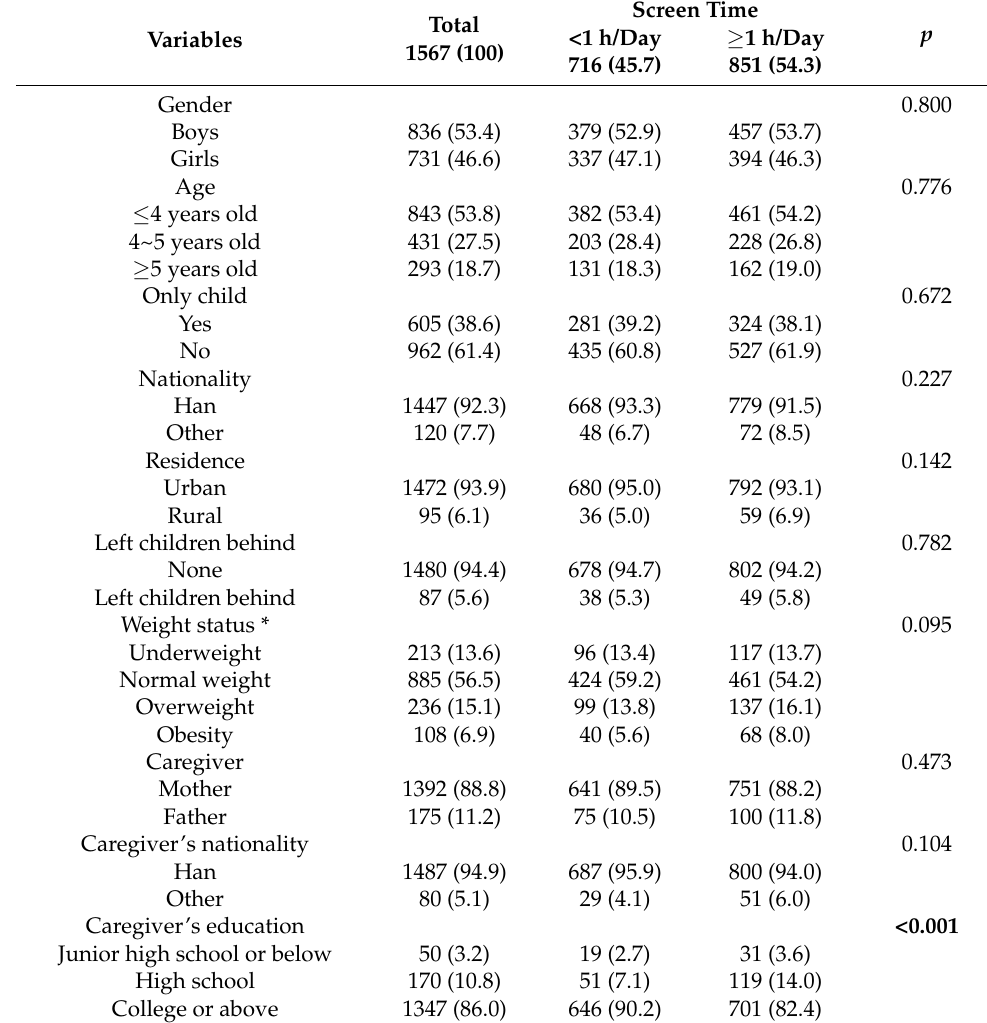
Table 1. Daily screen time by children’s characteristics ( n = 1567, %).